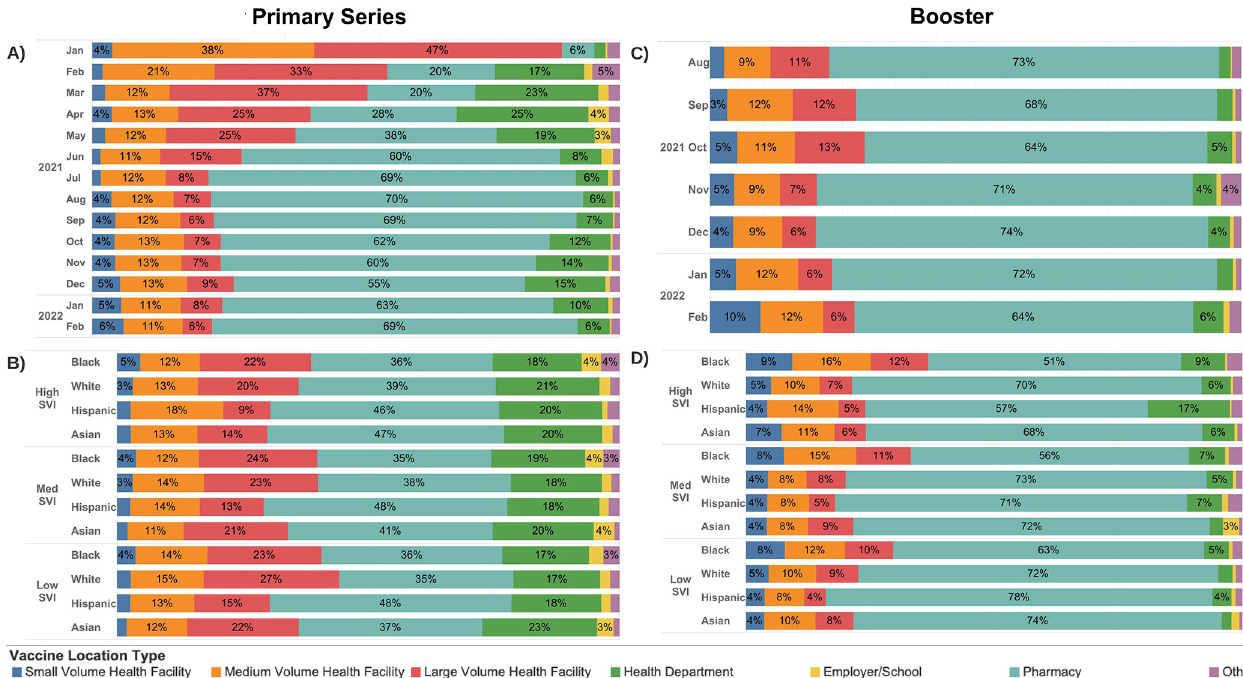
Fig 2. Distribution of primary COVID-19 vaccine series and boosters by location type over time and by SVI and race/ethnicity. Primary series and booster vaccination over time (A and C) and by SVI and race/ethnicity (B and D). Low SVI indicates zip codes with SVI less than 0.333, medium SVI indicates zip codes with SVI between 0.333 and 0.666, and high SVI indicates zip codes with SVI greater than AU : InthecaptiontoFig 2 ; forhighSVI ; Ichangedgreaterthanorequalto 0 : 666 togreaterthan 0 : 666 : Ifthisnotcorrect ; pleaseeditasnecessary : 0.666. Health facilities were categorized as small, medium, or large volume based on whether they vaccinated less than 1,000, 1,000 to 10,000, or greater than 10,000 unique individuals. Other facilities included dialysis centers, home health, nursing homes, mental health/psychiatric facilities, and correctional facilities. Primary series vaccines were allocated to the location where the series was completed. SVI, Social Vulnerability Index.